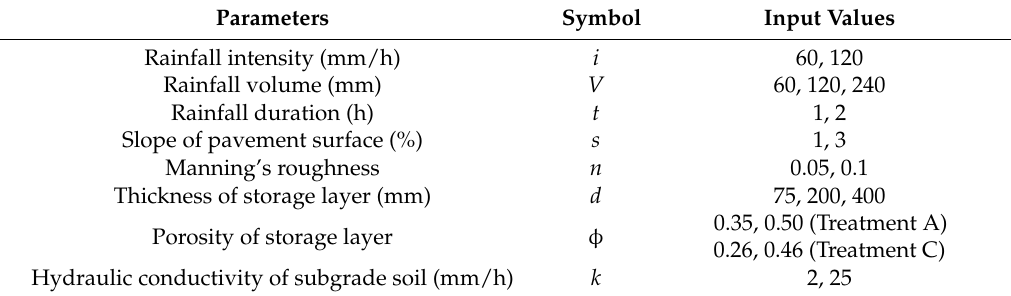
Table 3. Range of parameter values for Treatments A and C during the event-based